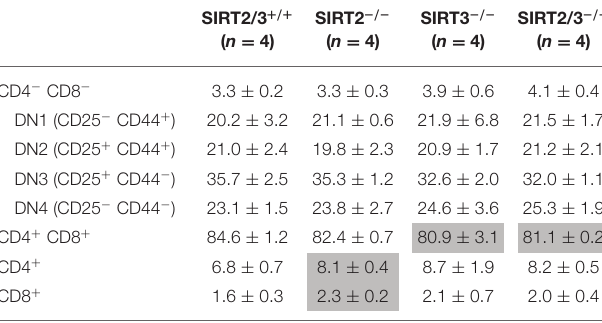
TABLE 2 | Thymic cell subsets.